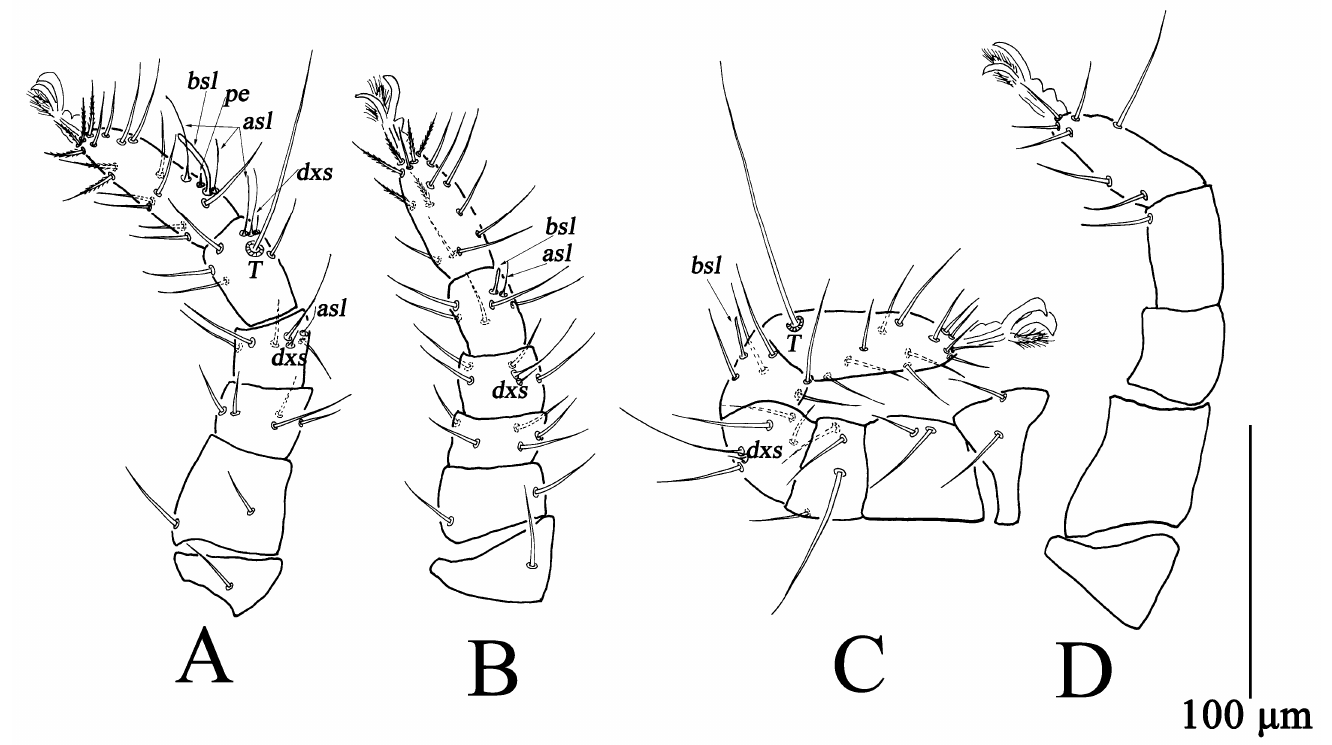
Insects 2022 , 13 , x FOR PEER REVIEW Figure 12. Bdella muscorum , protonymph: ( A ) Leg I; ( B ) Leg II; ( C ) Leg III; ( D ) Leg IV. Larva (n = 7) (Figures 13 and 14).